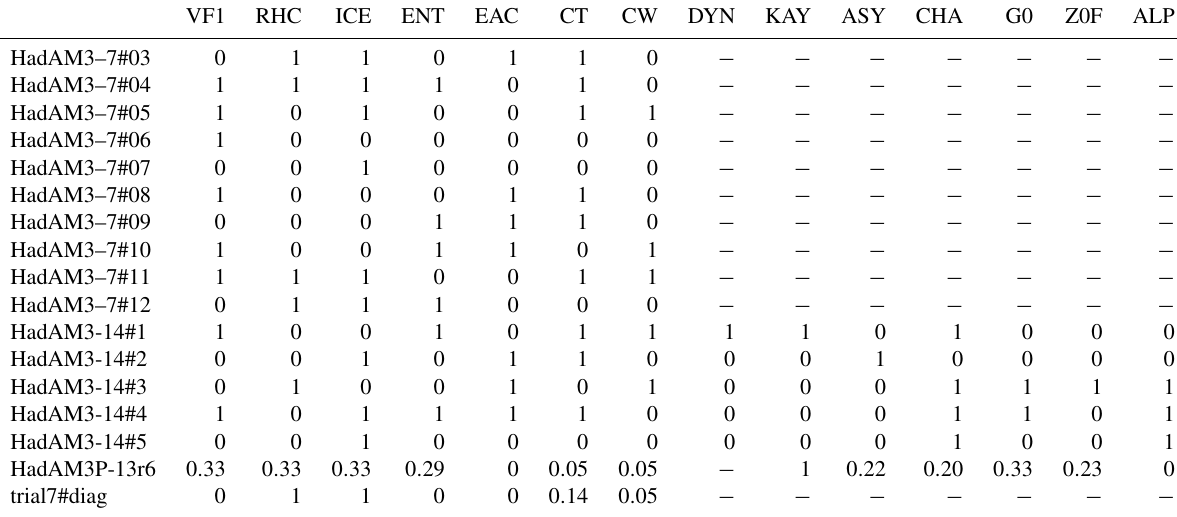
Table 3. Normalised initial parameters for 7- and 14-parameter, HadAM3P, and trial cases. All parameters are normalised by their expert- based ranges with 0 (1) being the minimum (maximum) values. Values not shown use the default HadAM3 (or HadAM3P) values. Parameter names are shortened to their first three characters. Initial parameters from the two 14-parameter random Gauss–Newton algorithms are not shown as they match the equivalent values from the standard Gauss–Newton algorithms. Similarly only the HadAM3P13r6 and trial7#diag cases are shown, as other HadAM3P and trial7 cases use the same values.